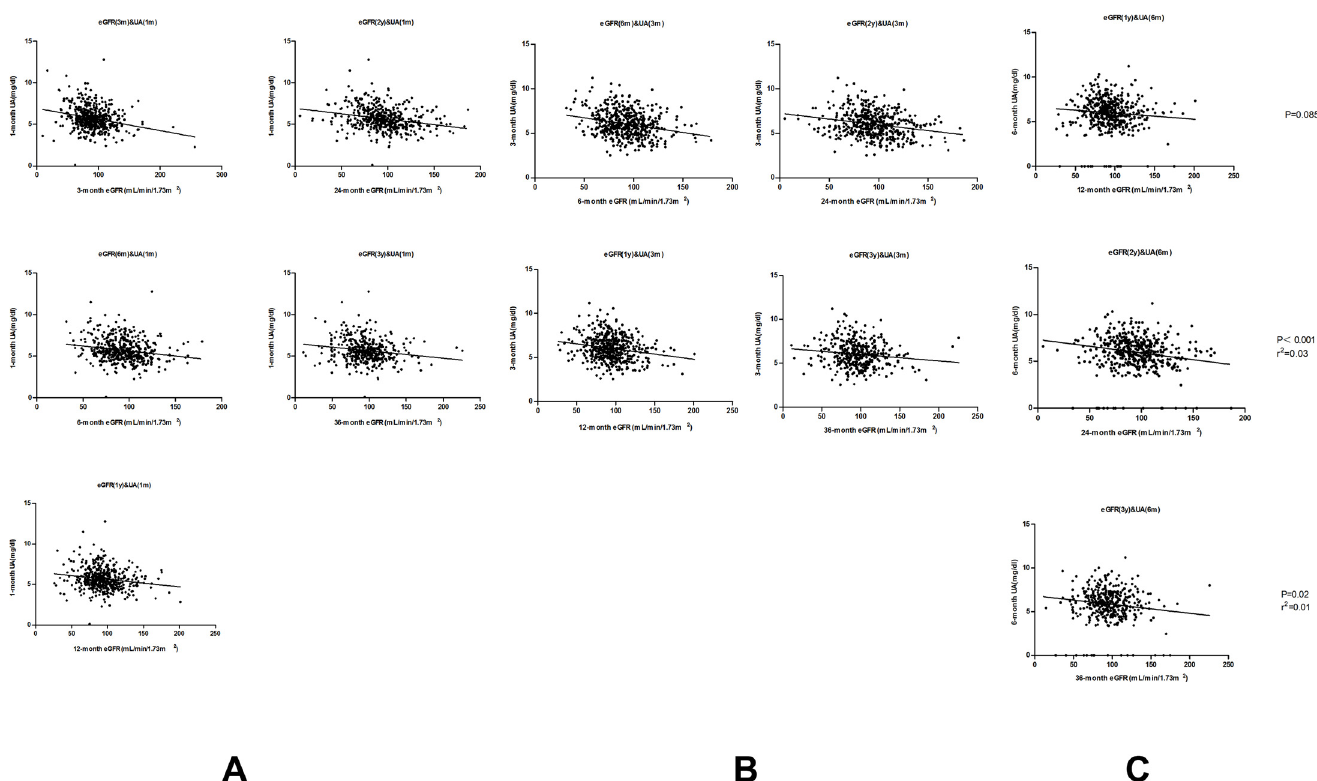
Fig 1. UA level predicts post-transplant kidney function. Scatter plots showed that UA level was negatively associated with eGFR at multiple times post- transplant. (A) This part showed the correlations between 1-month UA and 5 different time points eGFRs post-transplant. (B) The same correlation between 3-mont UA and 4 other time points. (C) 6-month UA cannot predict future eGFRs properly.